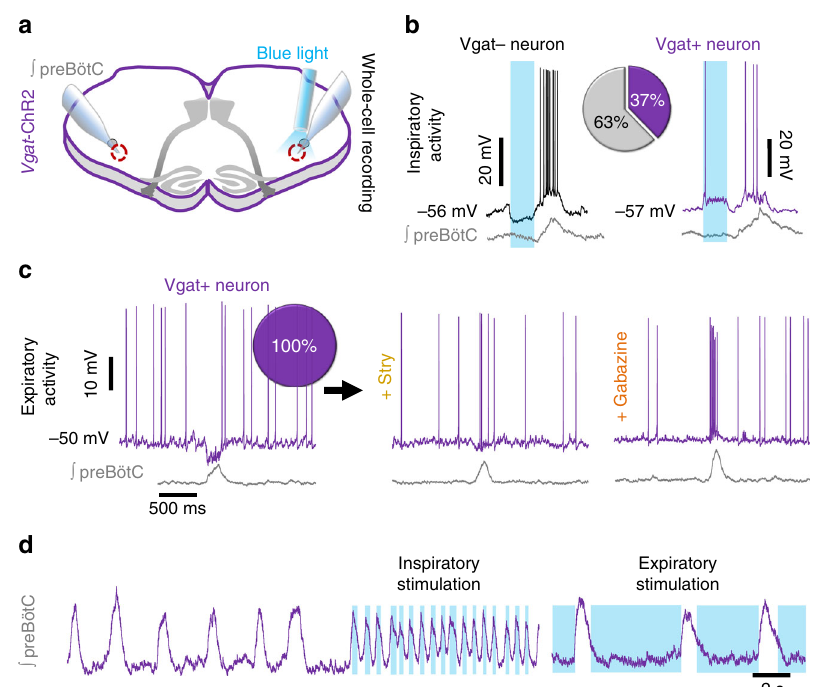
Fig. 4 PreBötC inhibitory neuron populations have distinct effects on inspiratory burst frequency. a Diagram of Vgat -ChR2 brainstem slice con fi guration used to identify inhibitory preBötC neuron activity relative to preBötC burst phase. b Representative activity of a Vgat − inspiratory neuron showing post-inhibitory rebound following light stimulation (left) and a Vgat + neuron with inspiratory activity (right). 14/37 (37%) recorded inspiratory neurons were inhibitory. c Example Vgat + expiratory neuron at baseline and during blockade of synaptic inhibition with strychnine (1 µ M) and gabazine (1 µ M) ( n = 3). Note that expiratory activity transitions to inspiratory activity following blockade of synaptic inhibition. 10/10 (100%) recorded expiratory neurons were inhibitory. d Example recording of preBötC population activity from a Vgat -ChR2 slice during phase-speci fi c light stimulation. Average data shown in Fig.